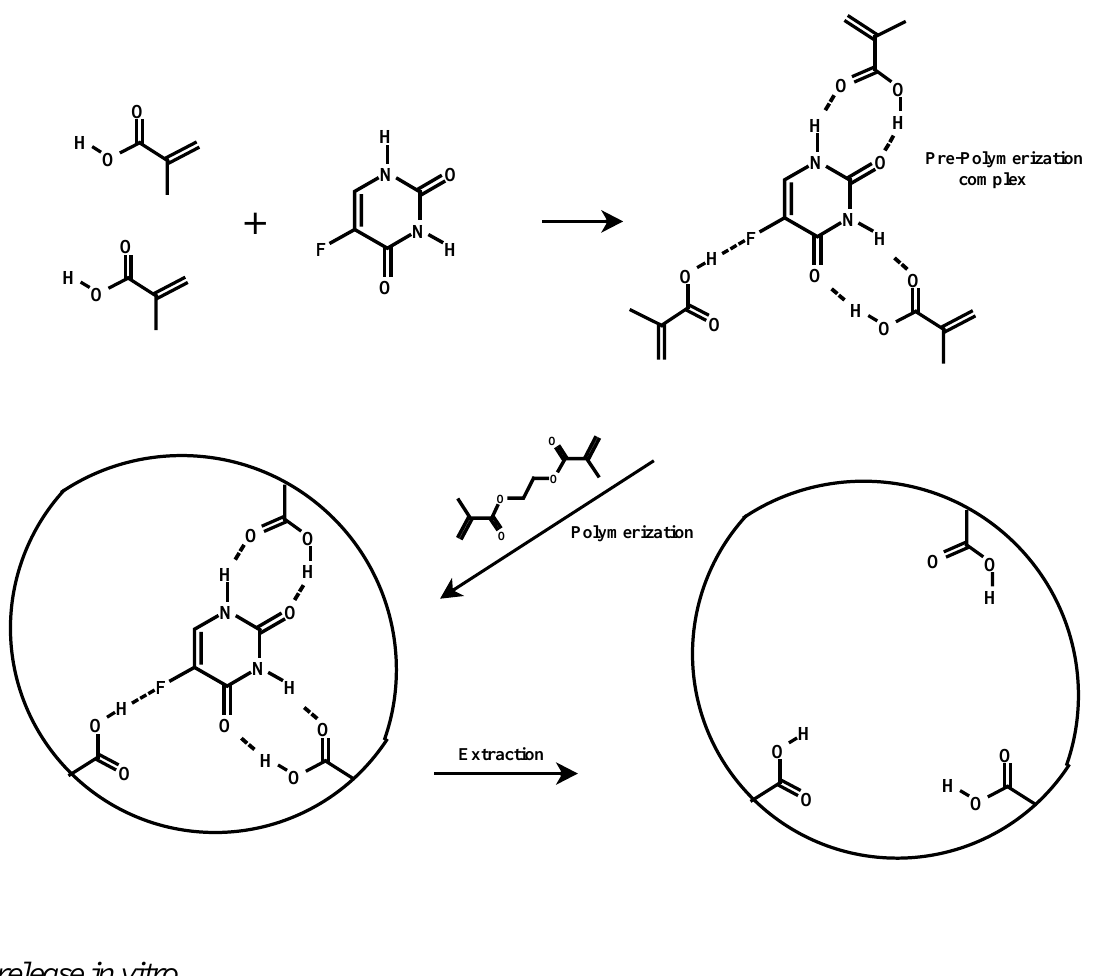
Figure 3. Schematic representation of 5-FU imprinting